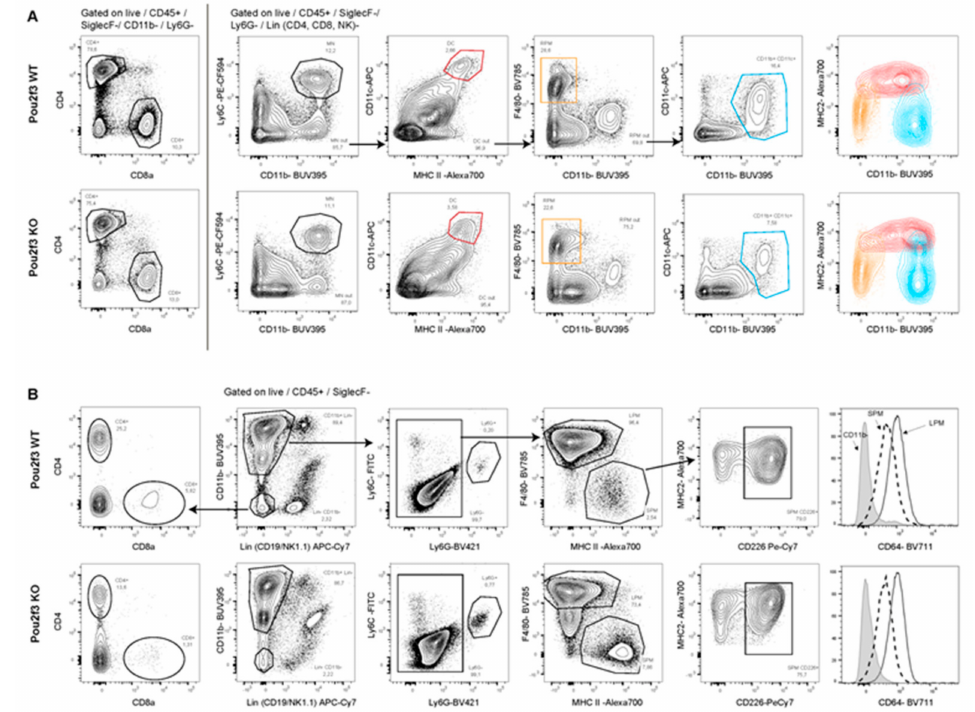
Figure 5. Immunophenotyping of cells from spleen and peritoneal cavity is similar in both genotypes. Cell sorting by flow cytometry of spleen cells ( A ) and from peritoneal cavity ( B ) from PKI;POU2F3 +/+ and PKI;POU2F3 − / −